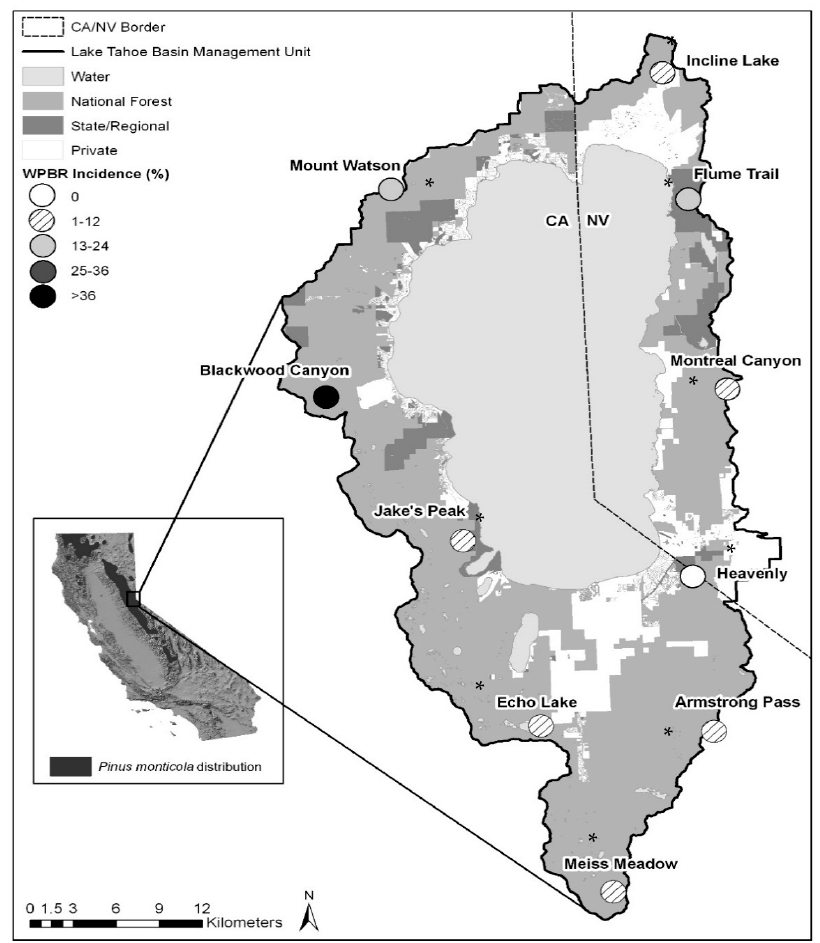
Figure 1. Location of study area and western white pine plots in the Lake Tahoe Basin. Pinus monticola distribution in California is shown in insert (distribution map source USGS 1999 Digital representation of “Atlas of United States Trees” by Elbert L. Little, Jr.). Populations with Cr2 are noted and asterisks indicate populations where pollen receptors are